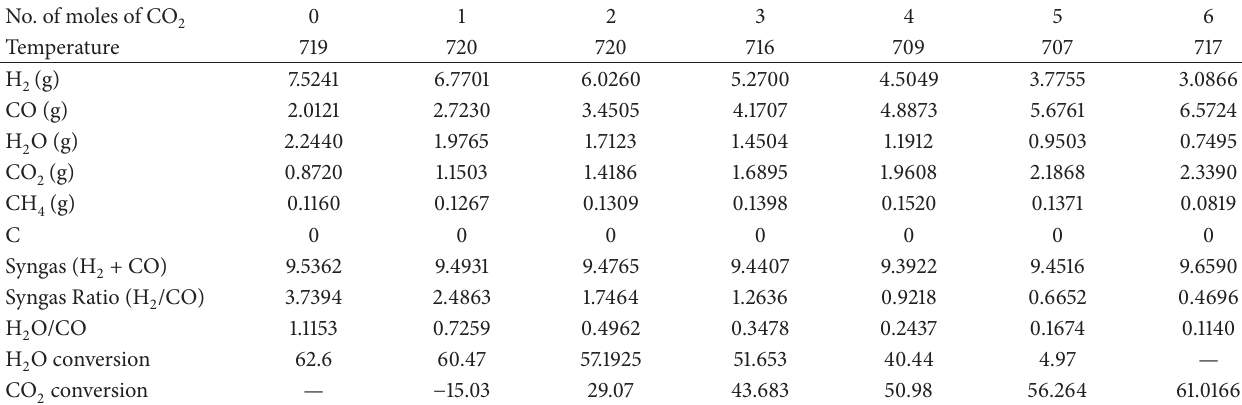
Table 4: Optimum parameters in combined reforming of propane at case OxPR =